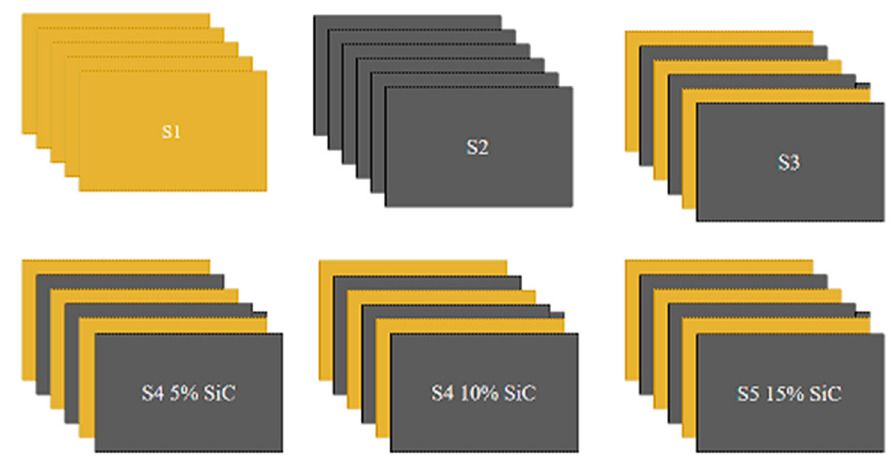
Figure 2. Different stacking sequences used for fabrications.